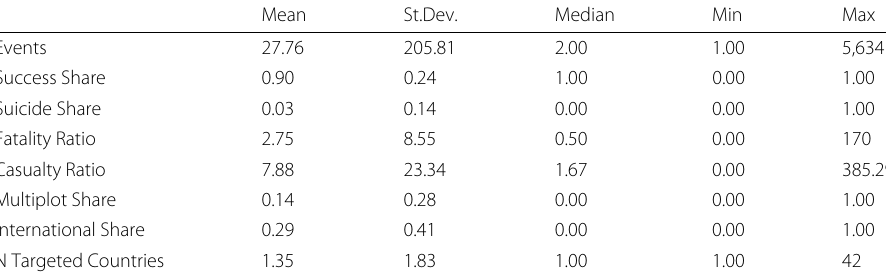
Table 2 Group-based Attributes on Terrorist Activity - Descriptive